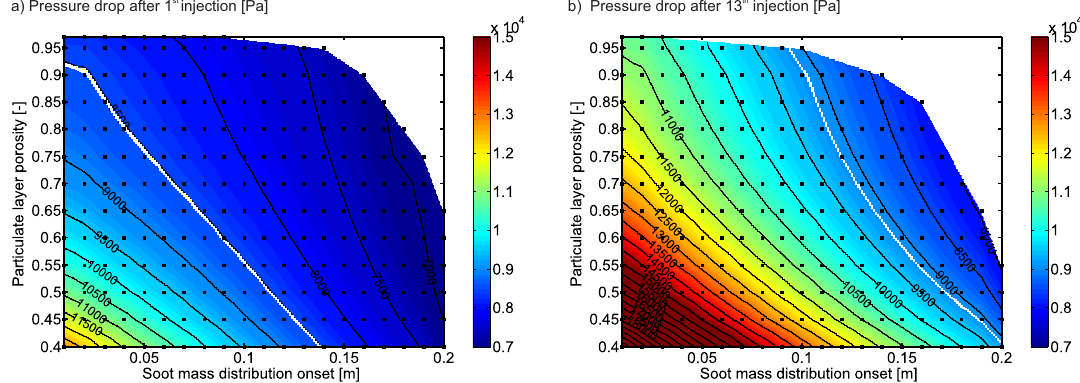
Figure 12. DPF pressure drop as a function of the particulate layer porosity and the soot mass distribution onset in DPF #A imposing a linear soot mass distribution.